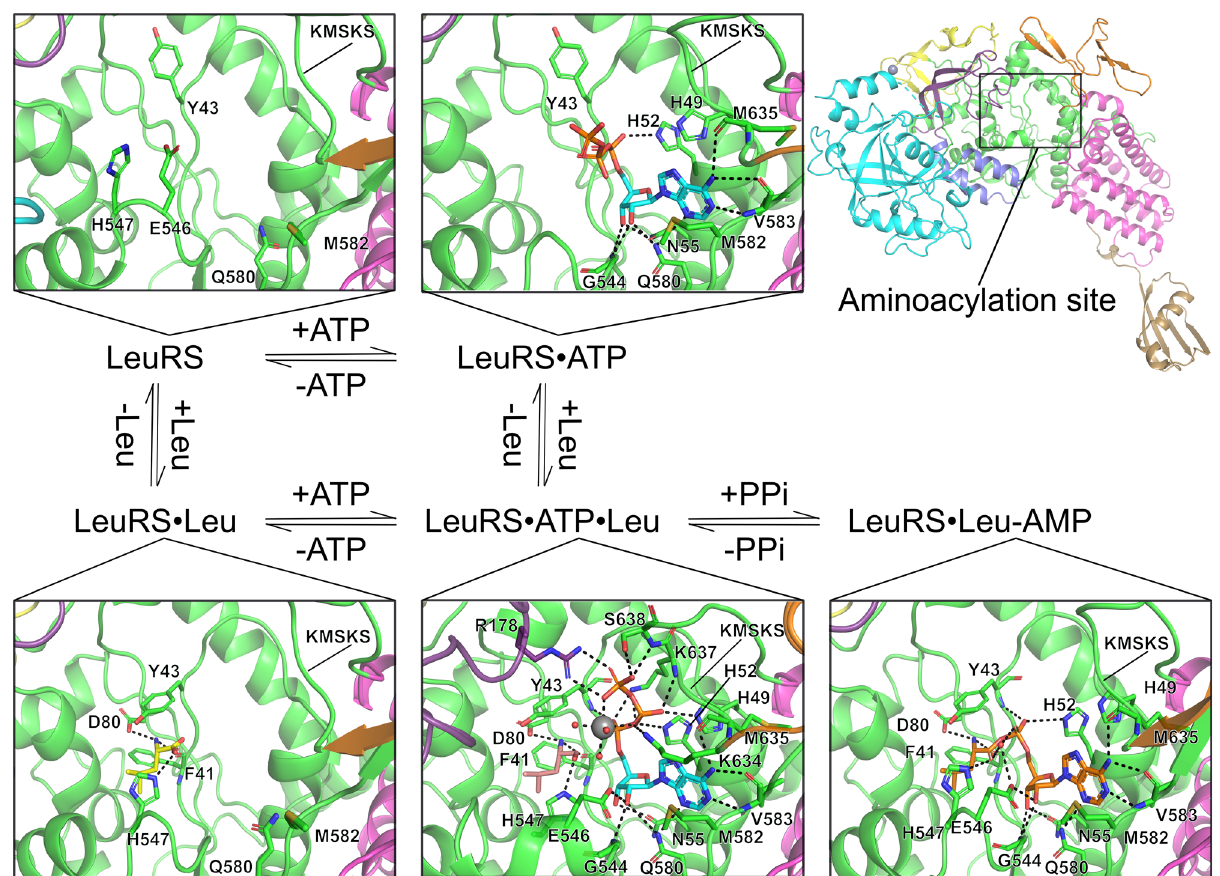
Fig. 2 Snapshots of each catalytic step during Leu-AMP formation. All protein structures are shown as cartoon representations whereas ligands and interacting protein residues are shown as sticks. All H-bonds and salt bridges are shown as black dashed lines. A magnesium ion is shown as a gray sphere while its coordinating water molecules are shown as small red spheres. All structural domains are colored as shown in Fig. 1c. Substrates ATP (cyan), Leu (yellow), Leu analog L -leucinol (salmon), and the reaction intermediate Leu-AMP (orange) are shown as sticks. The NgLeuRS·ATP·leucinol ternary complex mimics the pre-transition state where both ATP and Leu are bound in the productive conformation in the aminoacylation